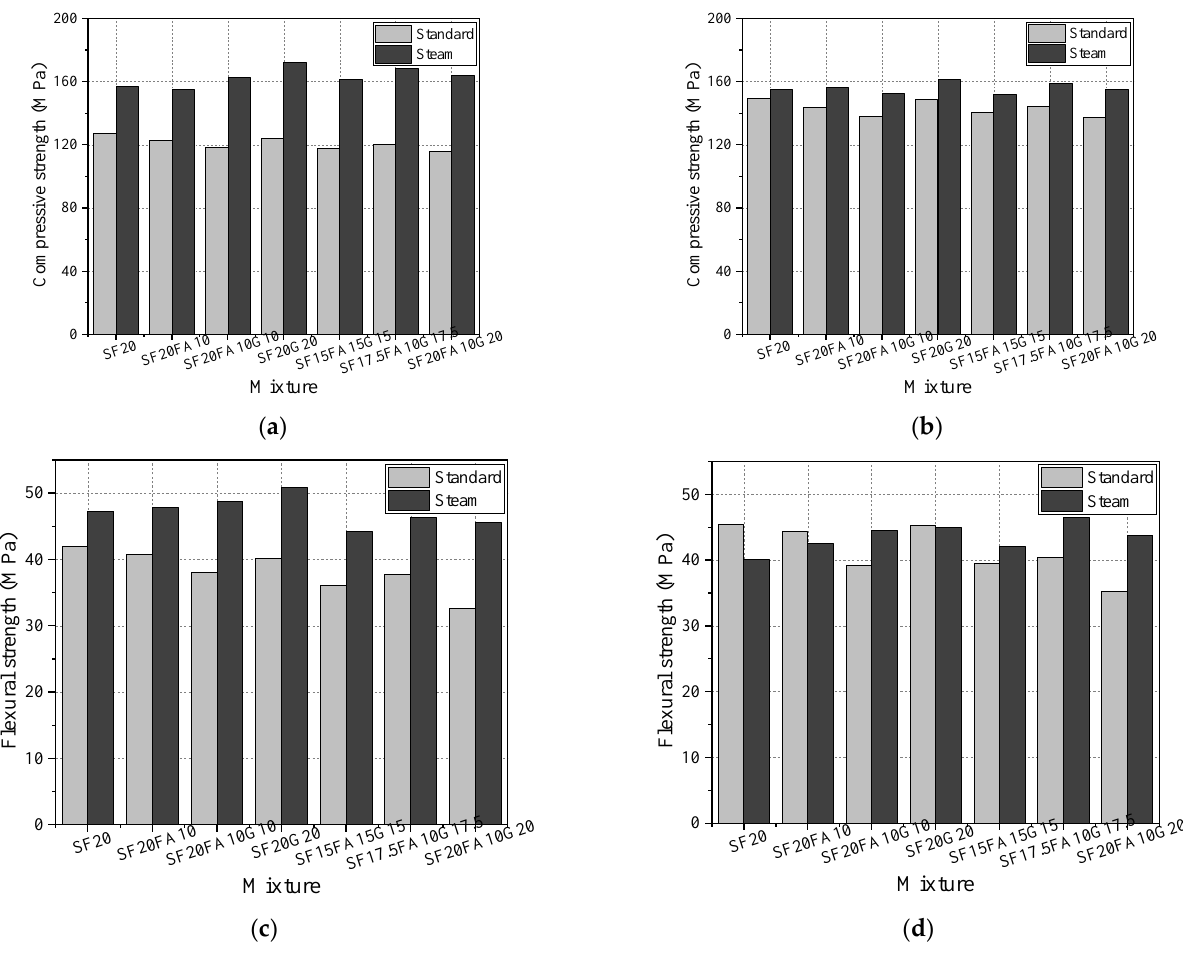
Figure 3. Compressive and flexural strength of EUHPC under different curing regimes: ( a ) compressive strength at 7 days; ( b ) compressive strength at 28 days; ( c ) flexural strength at 7 days; ( d ) flexural strength at 28 days.